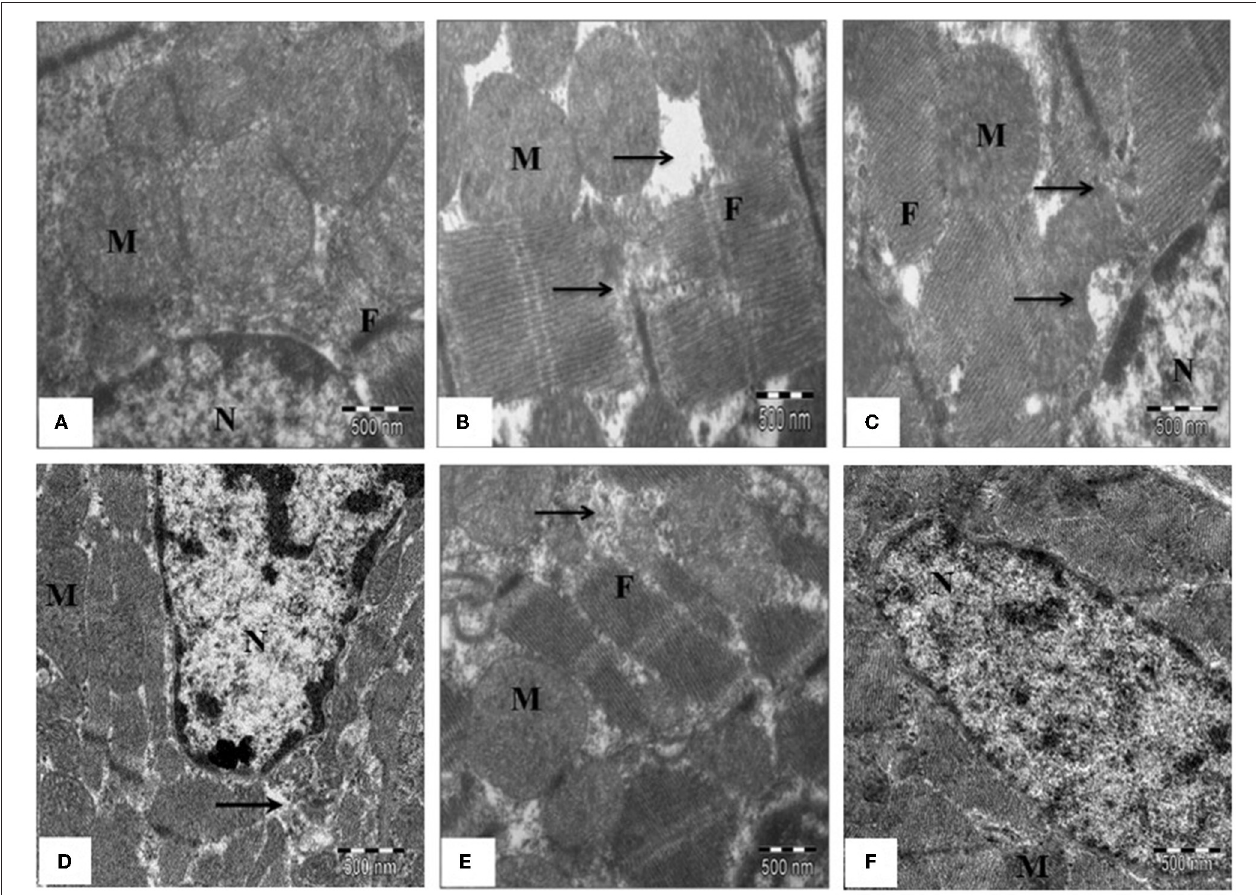
FIGURE 5 | The effect of SBT pulp oil on myocardium ultrastructure (scale bar: 500nm). (A) Sham; (B) Ischemia-reperfusion control; (C) Seabuckthorn pulp oil 5 ml/kg/day + ischemia-reperfusion; (D) Seabuckthorn pulp oil 10 ml/kg/day + ischemia-reperfusion; (E) Seabuckthorn pulp oil 20 ml/kg/day + ischemia-reperfusion; (F) Seabuckthorn pulp oil 20 ml/kg/day per se ; ( n = 3; M: mitochondria; N: nucleus; F: myofibrils; Arrow ( → ) indicates myofibrillar